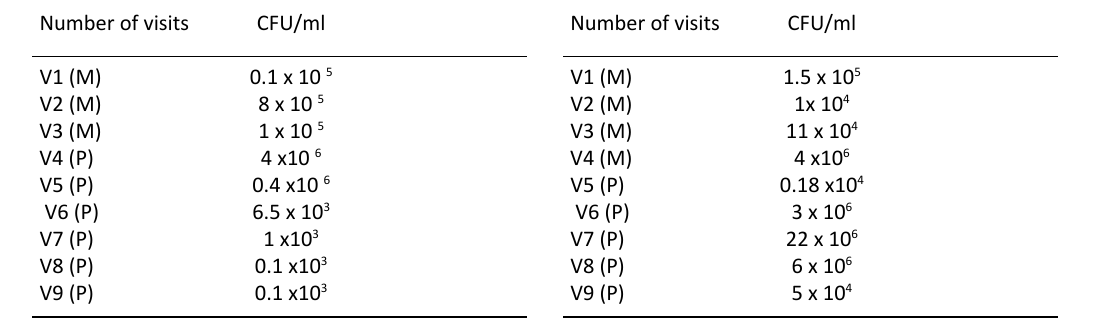
table 2. Total bacterial count (CFU/ml) of Hungarian cheese